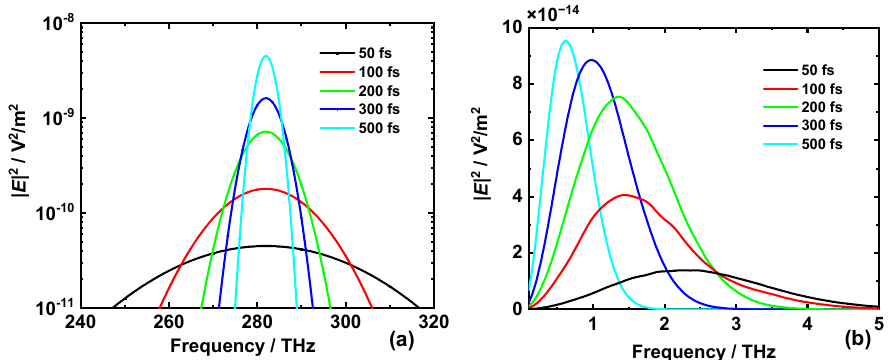
Figure 8. The spectra of the pump pulse at different pulse durations ( a ) and the corresponding generated terahertz spectra ( b ). The pump intensity was 30 GW/cm 2 at 1064 nm.